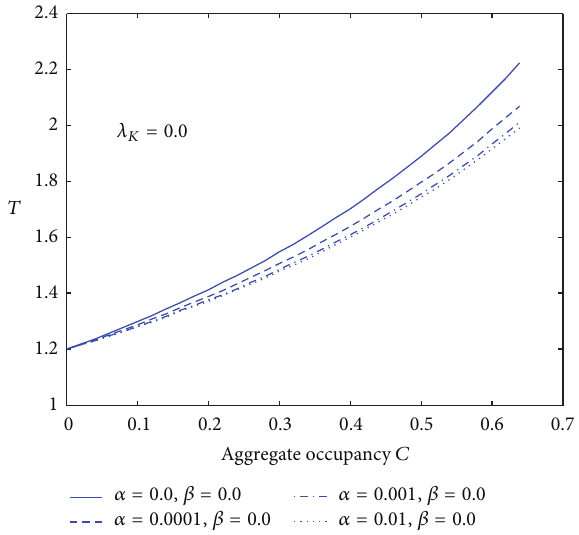
Figure 5: The change curve of the macroscopic inner friction coefficientwithaggregateoccupancyfordifferenttangentialsoftness = 0.0 ). 𝛼 of interfaces ( 𝜆 𝐾